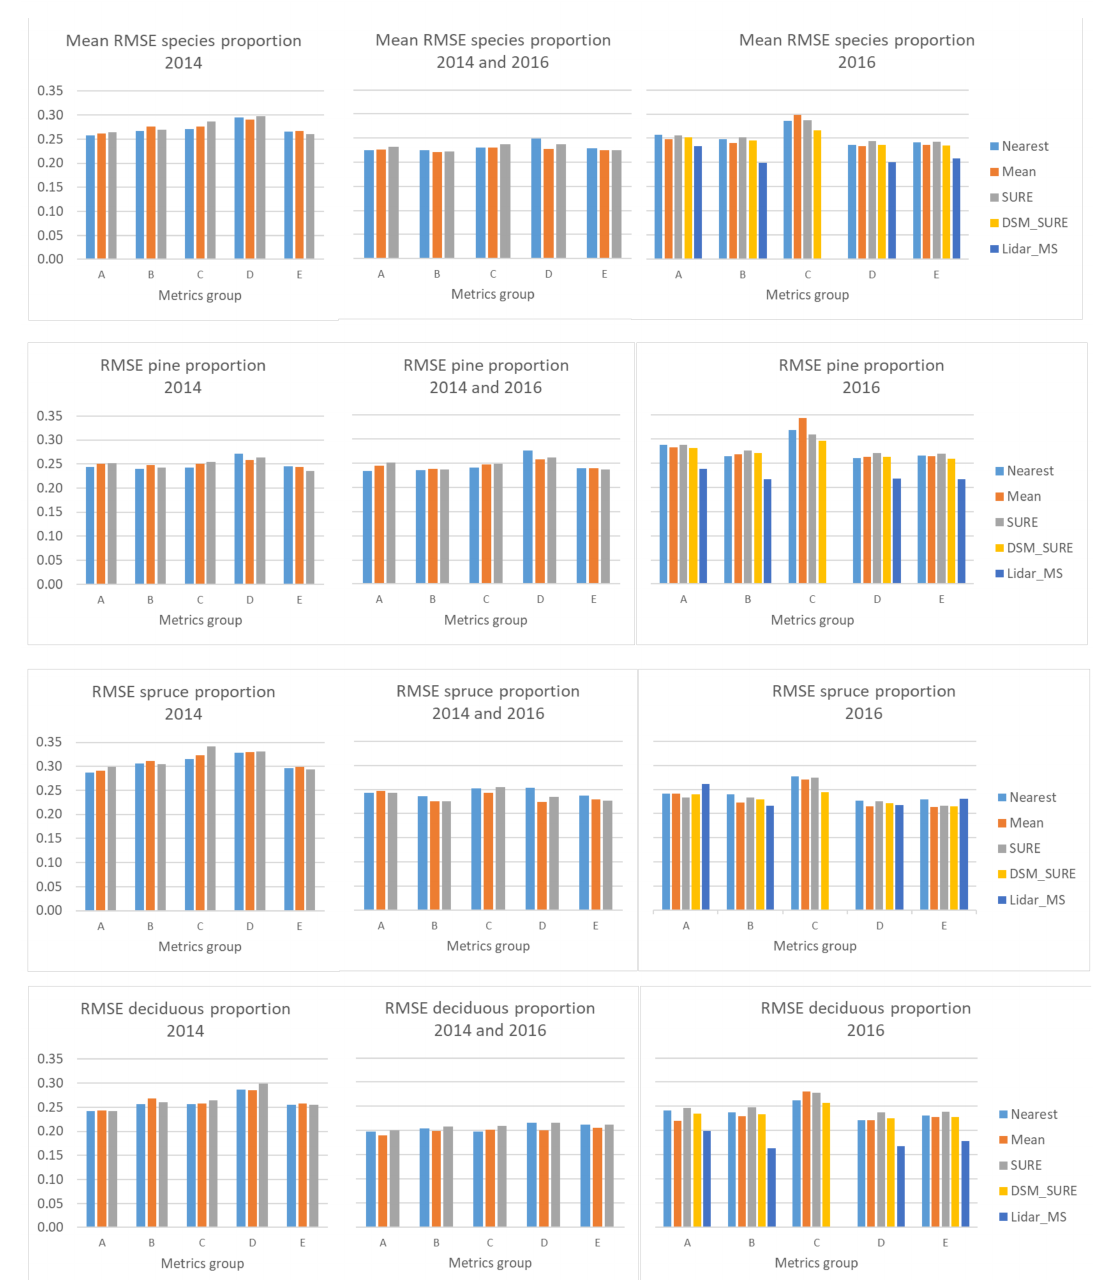
Figure 3. Bar plots of RMSE for the estimation of species-specific proportions for each metrics group and colour method for data set 2014; data set 2014 with spectral metrics from 2016; data set 2016 as columns. Mean and species-specific proportions are shown in the